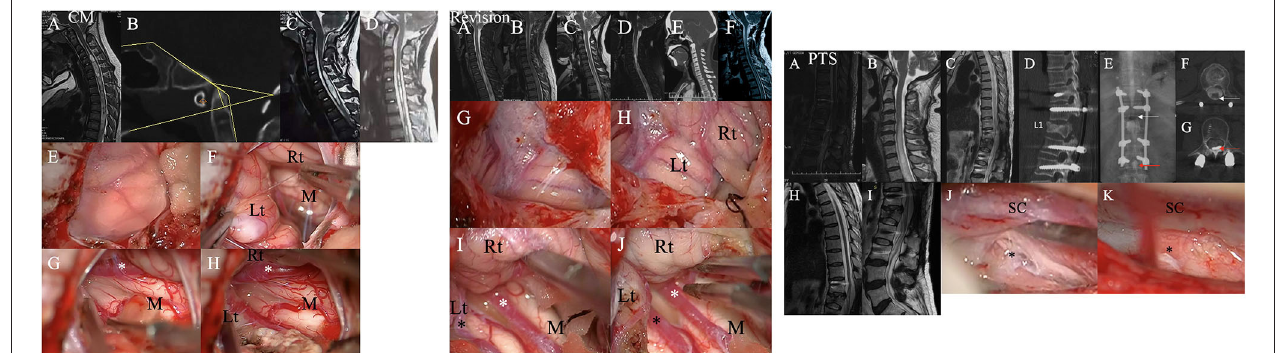
FIGURE 5 | Left chart: Representative case from the CM group. A patient was found to have syringomyelia due to facial paralysis. (A) Schematic drawings of the foramen magnum region. Midsagittal T2-weighted MRI scans of the craniocervical region and CT scans suggested that there was no other instability or basilar invagination (B) . The ratio of the syrinx/canal from A to B three (C) months after the initial surgery and 30 (D) months after the initial surgery. (E,F) A hypertrophic tonsil obstructing the foramen of Magendie. (G,H) The right posterior inferior cerebellar artery (PICA) (asterisk) obstructing the foramen of Magendie was lysed, and the tonsil was coagulated. Lt, Left tonsil; Rt, Right tonsil; M, Medulla oblongata. Middle chart: Representative case from the revision group. (A) Preoperative sagittal T2-weighted MRI showed a large syrinx. (B) 3 months, (C) 9 months, and (D) 3 years after the first surgery. (E) CT showed partial bone defects of the occipital bone and persistent syringomyelia. (F) Postoperative MRI 2 years after the second surgery showing obvious reduction of the syringx. (G,H) A hypertrophic tonsil obstructing the foramen of Magendie. (I,J) The PICA (asterisk) obstructing the foramen of Magendie was lysed, and the tonsil was coagulated. Lt, Left tonsil; Rt, Right tonsil; M, Medulla oblongata. Right chart: Representative case from the PTS group. (A) Postoperative sagittal T2-weighted MRI scan showed some oedema and internal fixation. (B–D) Sagittal T2-weighted MRI and CT after 2 years showed a large syrinx (up to C4 and down to L1) and an L1 compression fracture. (E–G) Myelography showed that the circulation of CSF was blocked at L1. (H,I) Postoperative sagittal T2-weighted MRI data showed obvious reduction of the syrinx. (J,K) : Obvious adhesions around the spinal cord at L1 were removed intraoperatively.